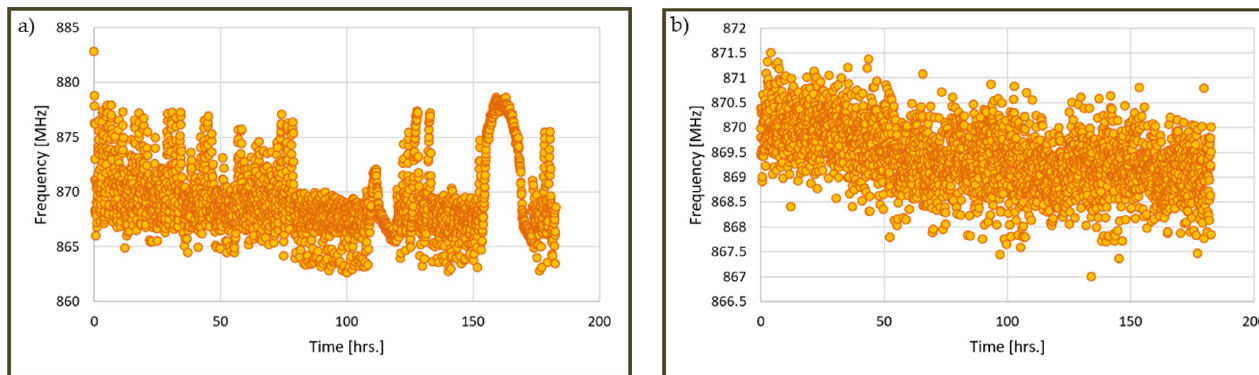
Figure 5. An example of degradation data before compensation ( a ) and after compensation ( b ). The stress conditions are a 45 °C ambient temperature and a core voltage of 1.1 V. stress conditions are a 45 ◦ C ambient temperature and a core voltage of 1.1